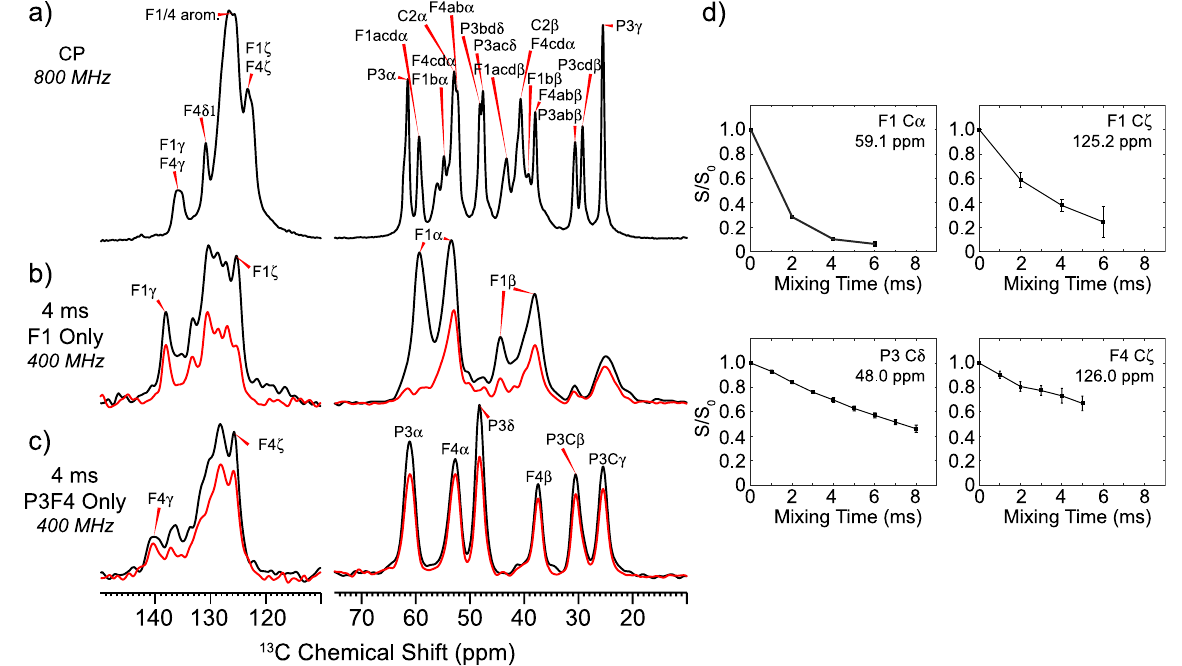
Figure 5. 13 C- 19 F distances are measured using 19 F-dephased and 13 C-detected REDOR spectra of the PFA- tagged π -clamp peptides. Representative spectra were shown. ( a ) 13 C CP-MAS spectra of the fully labeled peptide 6 , showing the aliphatic (right) and aromatic (left) region. Full intensity (S 0 , black) and dephased (S, red) REDOR spectra at a REDOR mixing time of 4 ms for the F1-only labeled π -clamp peptide 7 ( b ) and P3F4-only labeled peptide 8 ( c ) are shown. ( d ) Experimental S/S 0 dephasing values for four representative 13 C